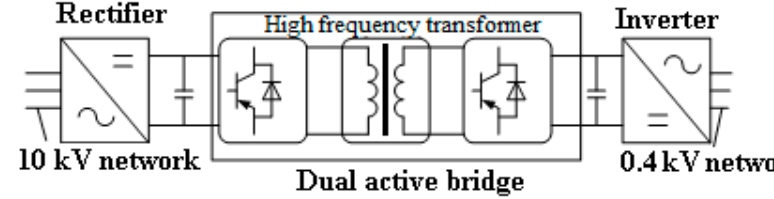
Figure 1. Three-stage power router topology.